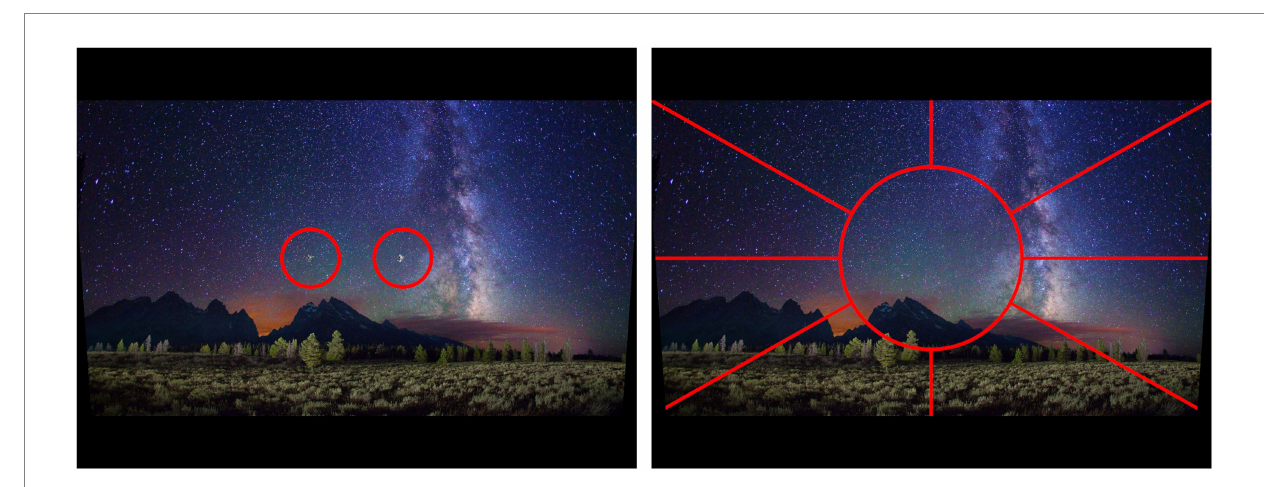
FIGURE 4 (Left) Selection of central target from two possibilities. (Right) Selection of peripheral target sector from eight possibilities. Adapted with permission from